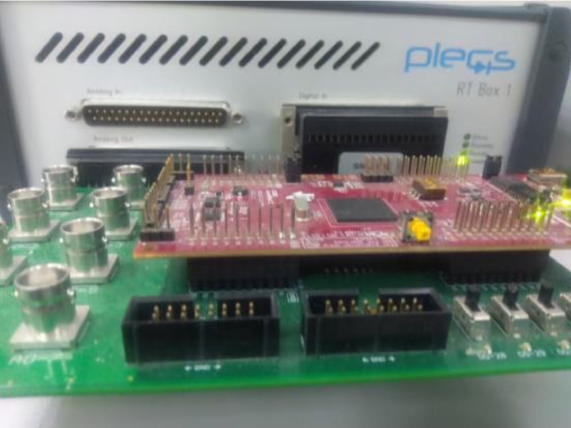
Figure 14. RTBOX1 and F28379D launchpad.